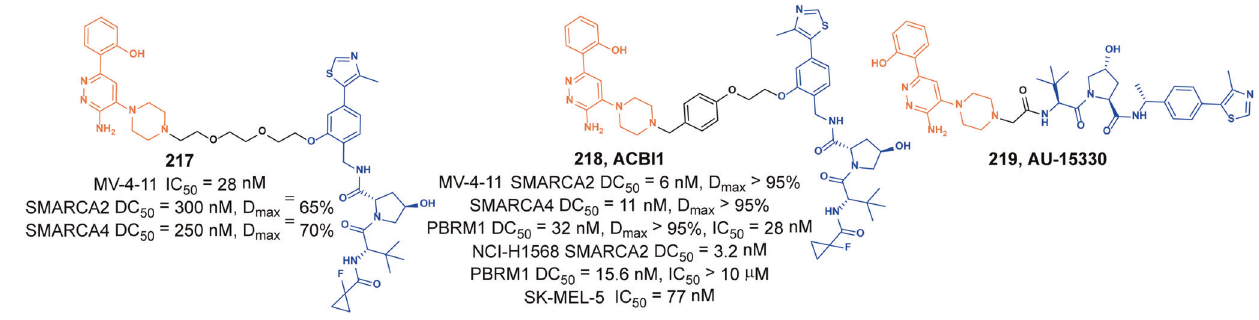
Fig. 70 The representative PROTACs targeting SMARCA2/4